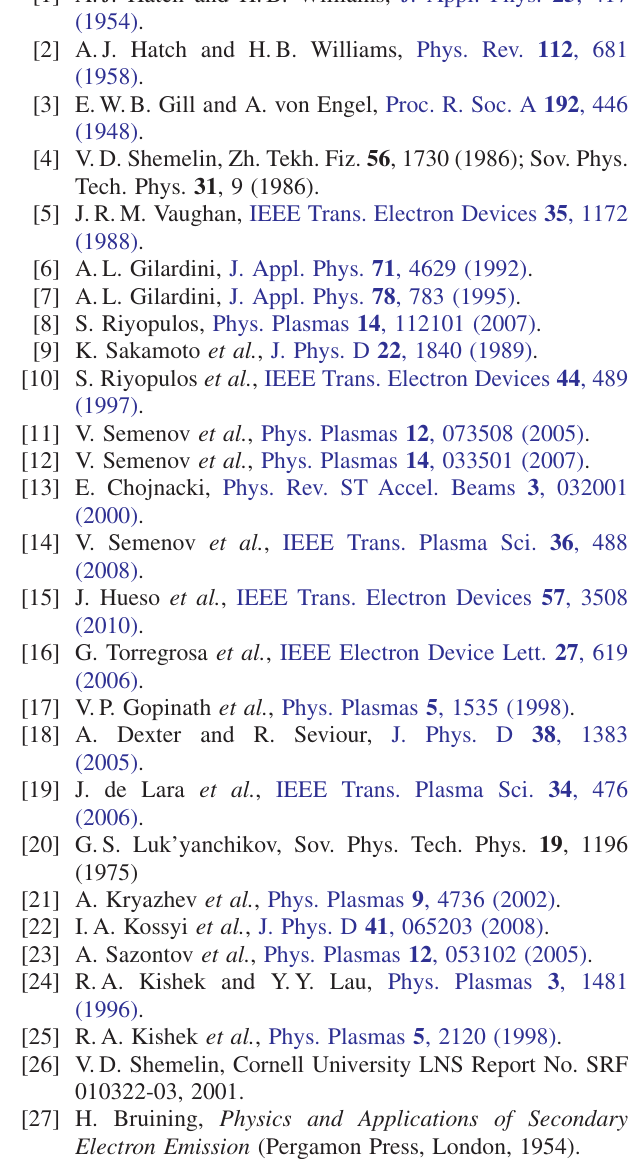
FIG. 9. Same as Fig. 8 but for the point C